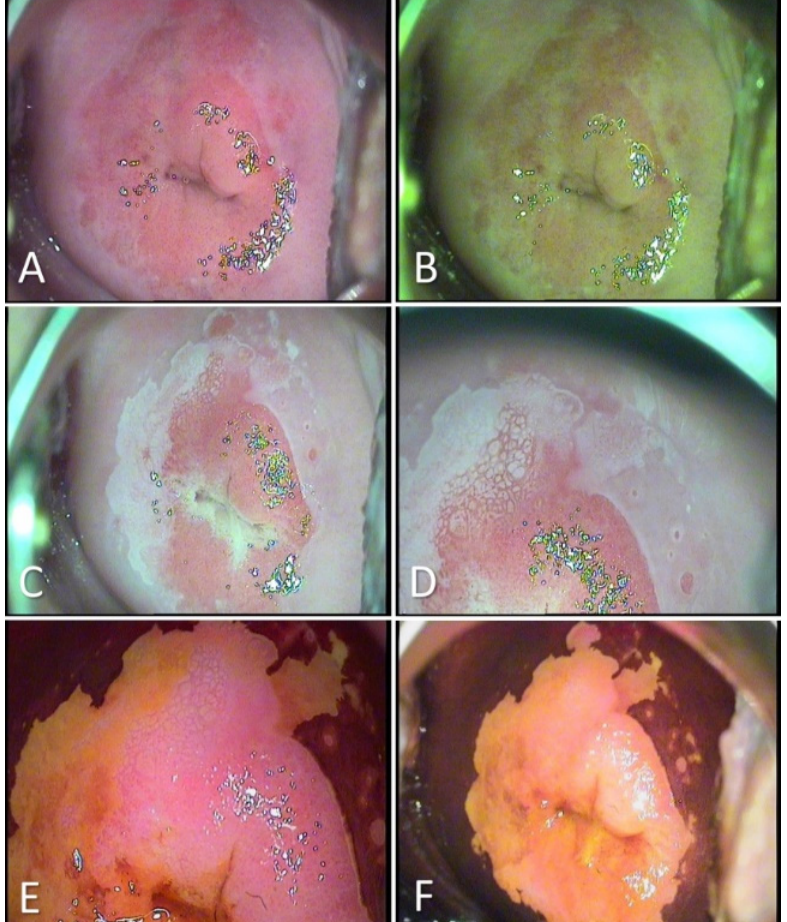
Figure 2. Colposcopic examination showing HSIL/CIN 2/3 cervical lesions. ( A ): After the application of saline: Native appearance, no visible lesion; ( B ): Evaluation in green light filter: does not highlight abnormal vessels; ( C , D ): After applying acetic acid: Aceto-white epithelium elevated, bright-white, and mosaic visible in three quadrants of the cervix; ( E , F ): After applying the Lugol solution: iodine- negative lesion, with well-contoured edges and circumferential extension.